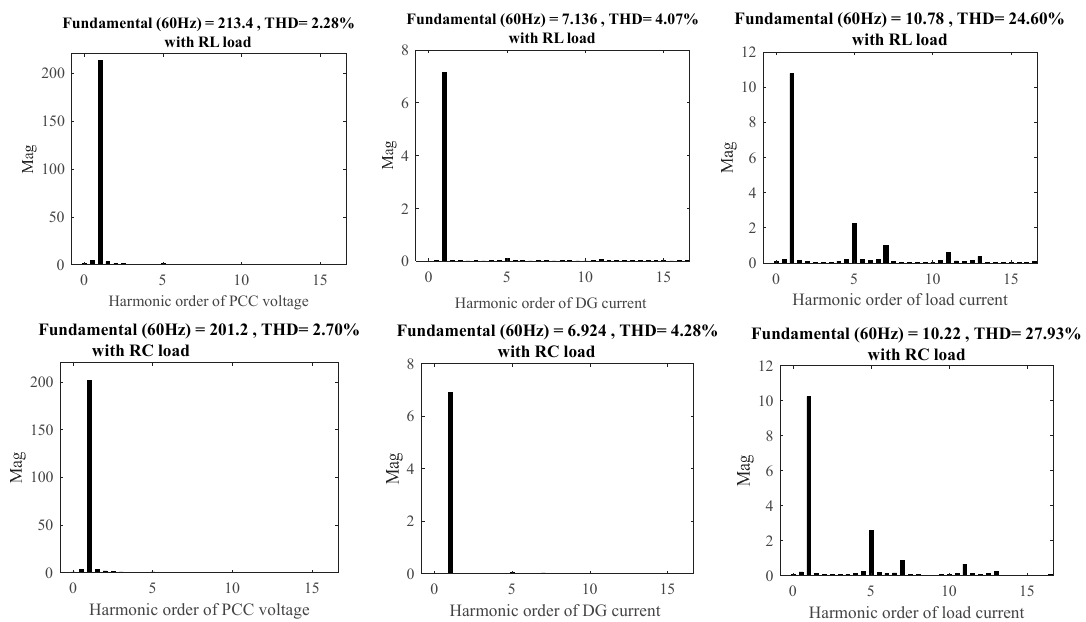
Figure 11. Harmonics spectrum of the PCC voltage, DG current and load current with RL and RC nonlinear loads.